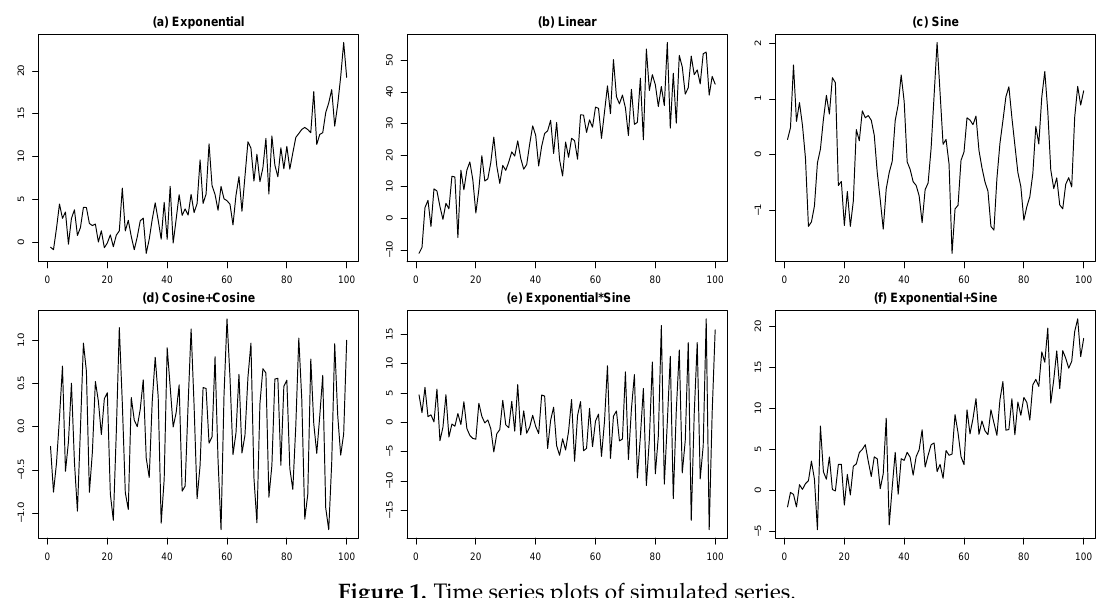
Figure 1. Time series plots of simulated series.